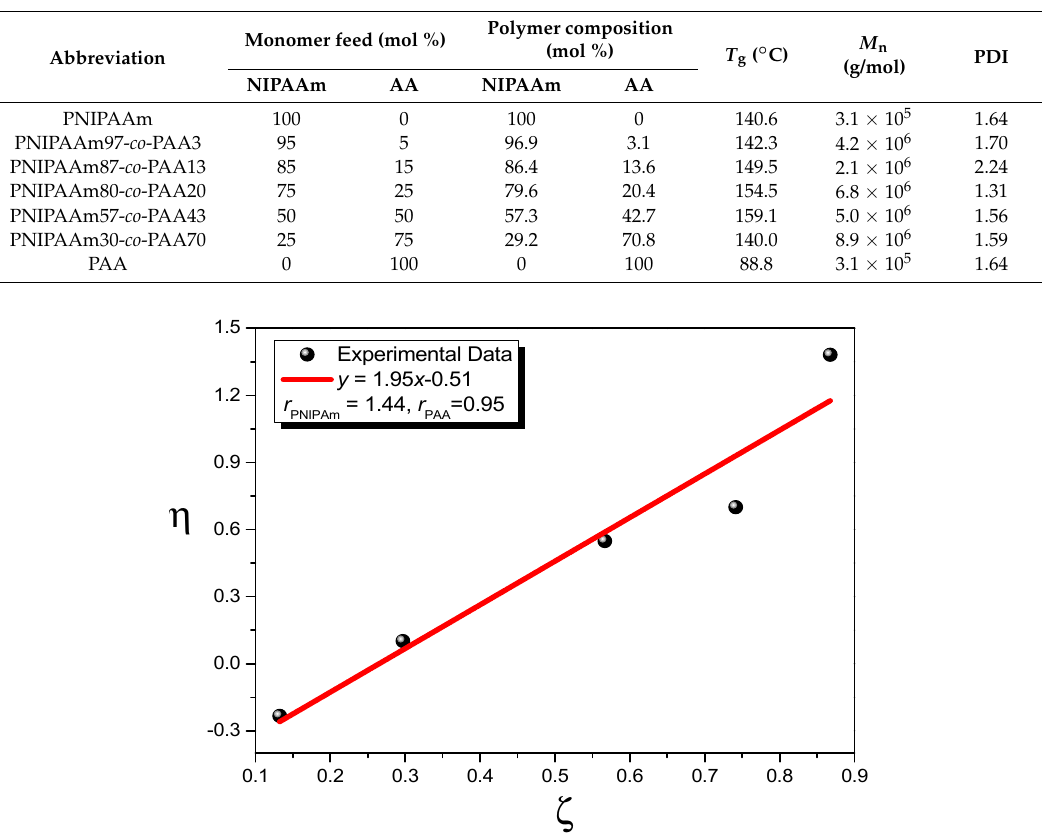
Figure 2. Kelen–Tudos plots of PNIPAAm- co -PAA random copolymers.